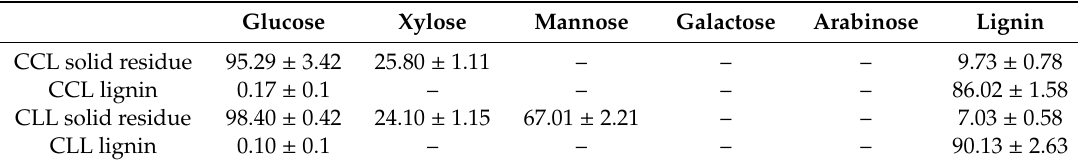
Table 2. Chemical compositions of DES solid residues and DES lignin (as a percentage based on the initial sample component). Glucose Xylose Mannose Galactose Arabinose